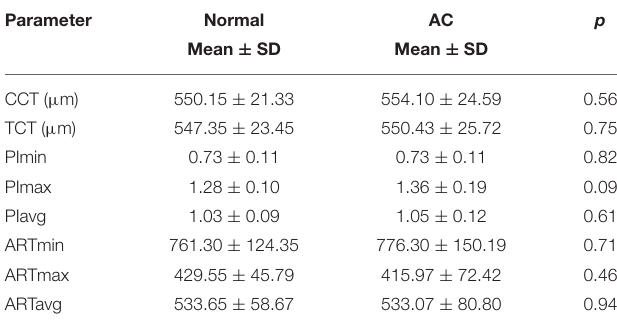
TABLE 1 | Demographics of the normal and AC groups. Characteristics